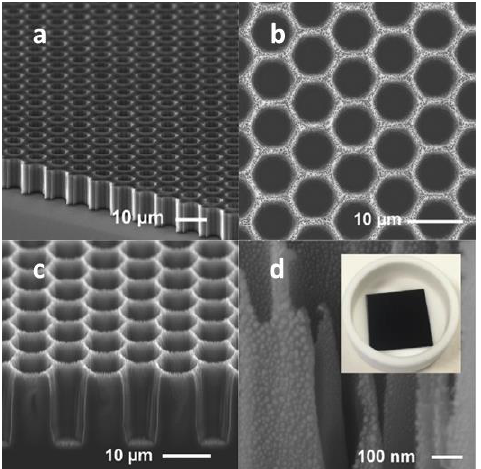
Figure 7. The SEM of order micro-nanostructure black silicon. ( a ) The cross-section SEM of black silicon after the first etching. ( b ) The top view of black silicon after the second etching. ( c ) The cross-section SEM of black silicon after the second etching. ( d ) The SEM of black silicon after Au deposition. Adapted from reference [68], with permission from Elsevier © 2020.